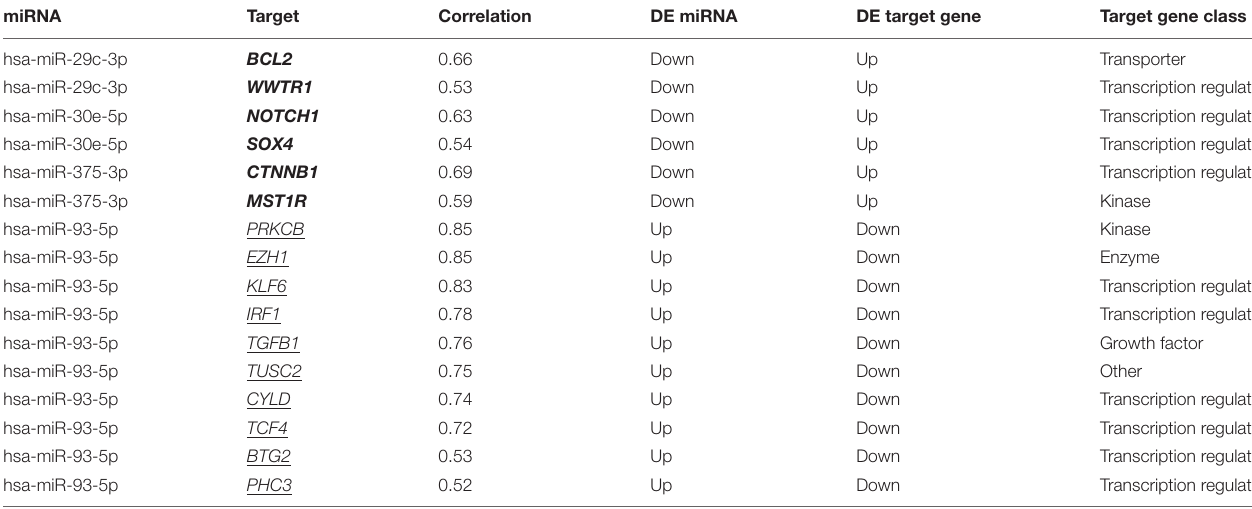
TABLE 3 | miRNA-targeted tumor suppressor genes and oncogenes. miRNA Target Correlation DE miRNA DE target gene Target gene